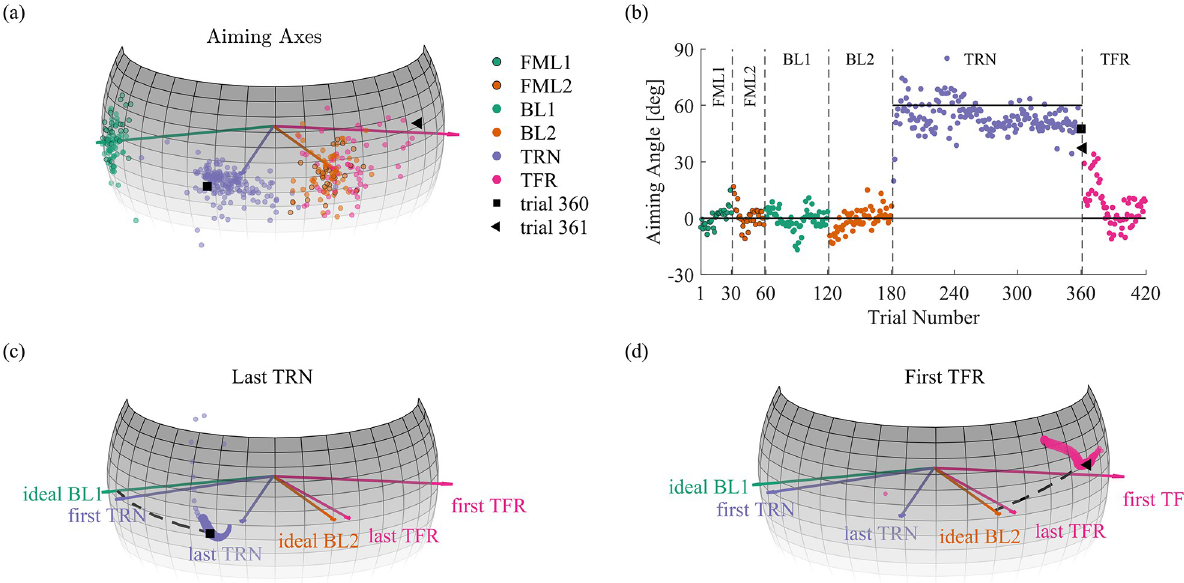
Fig 8. Aiming axes and angles of a single participant in the Extrinsic group. The colors are as in Fig 3. The FML1 trials are colored as The BL1 trials and enclosed by black circles, and the FML2 trials are colored as The BL2 trials and enclosed by black circles. (a) The course of the aiming axes. The last TRN axis and the first TFR axis are marked as a square and a triangle, respectively. (b) The time course of the aiming angles. The dashed lines separate between the different sets of trials, and the continuous lines indicate the ideal aiming angle at the BL session and the aiming angle required for full adaptation at the TRN session. (c) The rotation axes of the quaternion path in the last TRN trial. The extent of adaptation is the length of the arc that connects between the ideal BL1 axis and the aiming axis (i.e., the quaternion axis at the time of maximal angular speed, square). The arc reaches near the axis that represents full adaptation, which indicates that the participant had largely adapted. (d) The rotation axes of the quaternion path in the first TFR trial. The extent of transfer is the length of the arc that connects between the ideal BL2 axis and the aiming axis (triangle). The arc reaches near the axis that represents full transfer, which indicates that the participant had fully transferred the adaptation to a new initial orientation. To emphasize fast rotation samples, the size of the dots is scaled in proportion to the angular speed in (c) and (d).